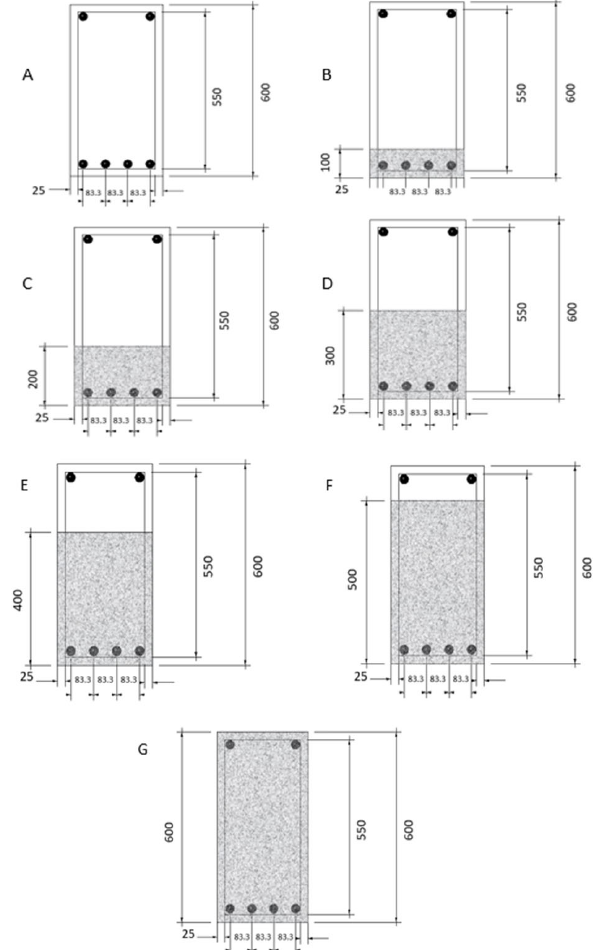
Figure 1. Designed cross-sections. ( A ) Reference beam. ( B ) Addition of SHC at 100 mm. ( C ) Addition of SHC at 200 mm. ( D ) Addition of SHC at 300 mm. ( E ) Addition of SHC at 400 mm. ( F ) Addition of SHC at 500 m. ( G ) Full SHC section.